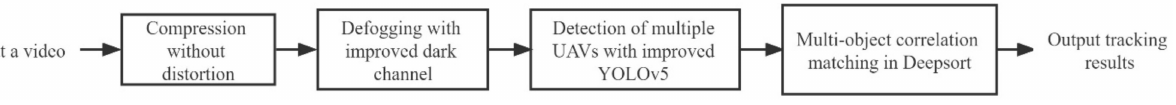
Figure 1. Process flow of tracking multiple UAVs in foggy